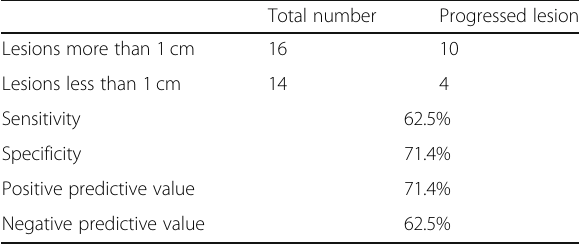
Table 1 Size progression of the lesions in the current study with assessment of sensitivity and specificity of size